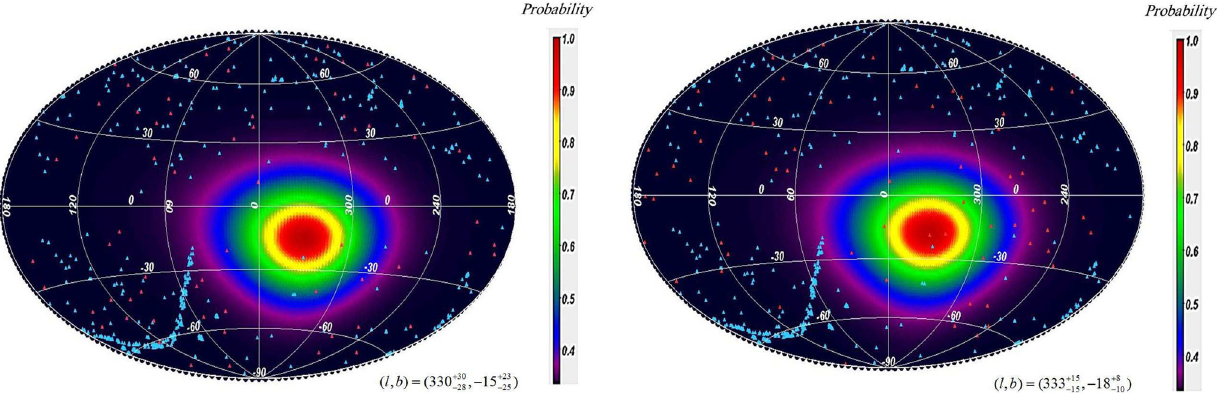
Fig. 3 Probability of dark energy dipole direction using 2 × 10 5 Union2 plus GRB data Blue and red triangles are Union2 and GRB data. Left:Chameleon, Right:Teleparallel